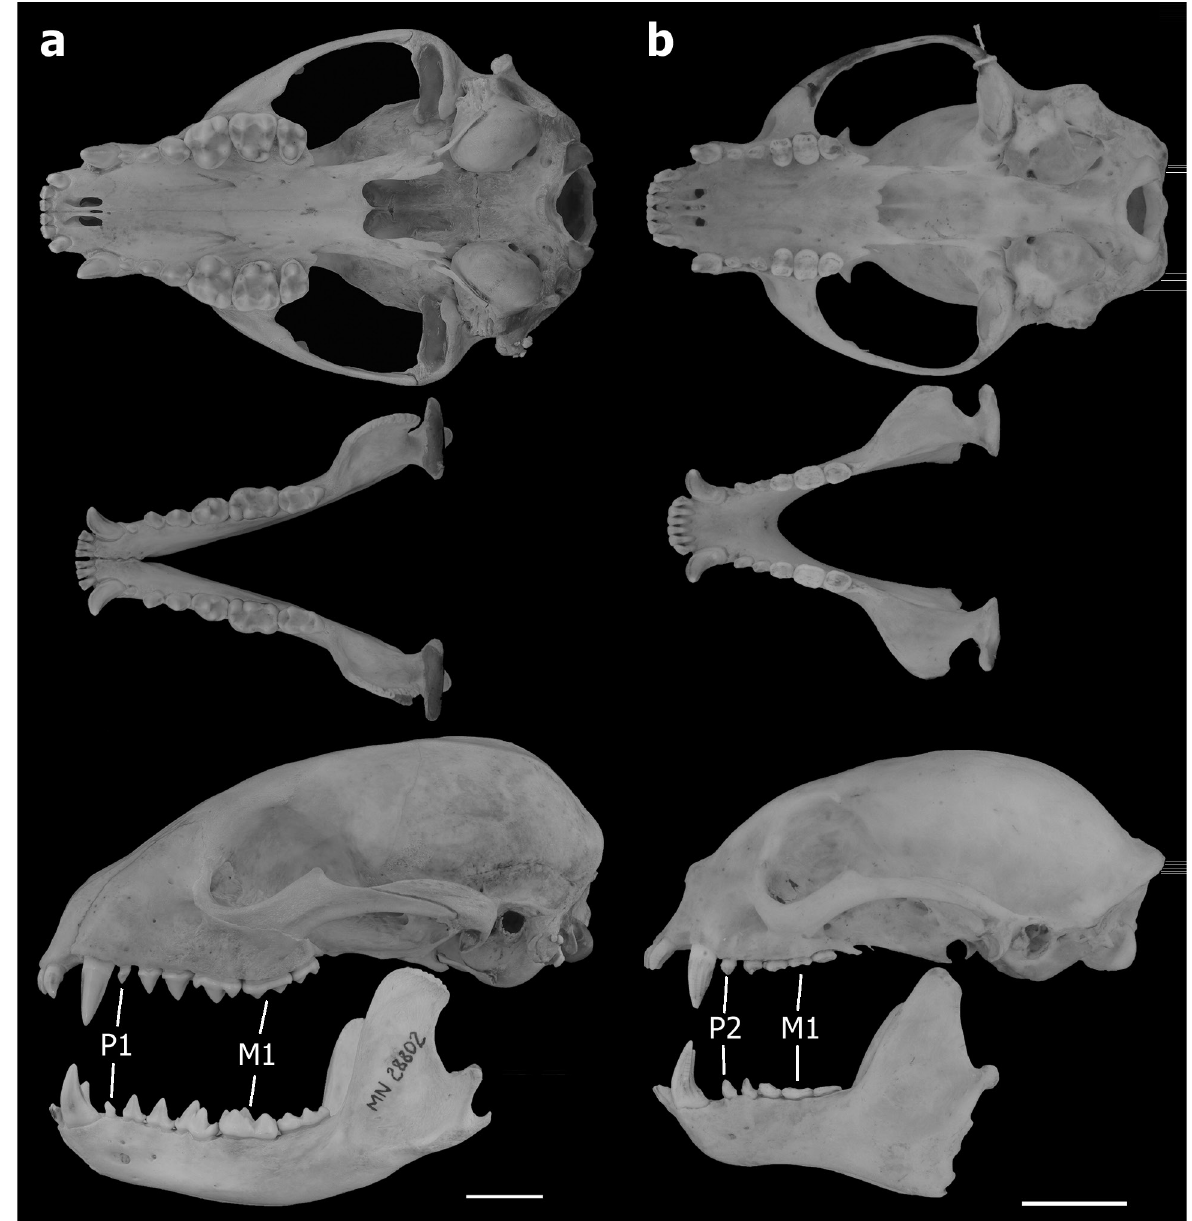
Figure 7. Occlusal (top) and lateral (bottom) views of the skull and mandible of: a) Procyon cancrivorus (MN28802); b) Potos flavus (MN68610). Abbreviation “P” means premolars and “M” molars. Scale bar =